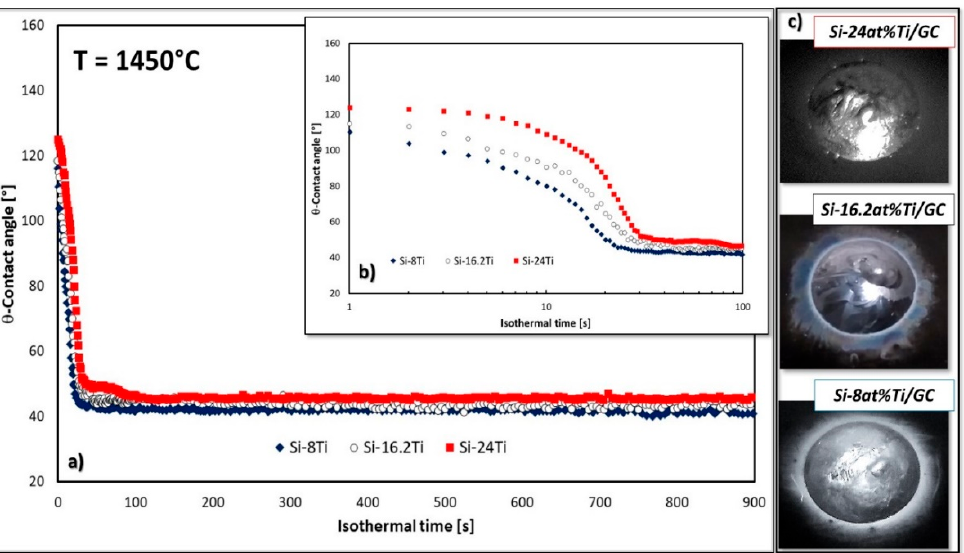
Figure 2. Contact angle behaviors at T = 1450 °C under an Ar atmosphere as a function of Si-content observed after ( a ) 900 s and ( b ) 100 s; ( ) Si-24at%Ti /GC, ( ) Si-16.28at%Ti/GC, ( ) Si-8at%Ti/GC; ( c ) related top view photographs of Si-Ti alloys/GC couples after the wetting experiments.